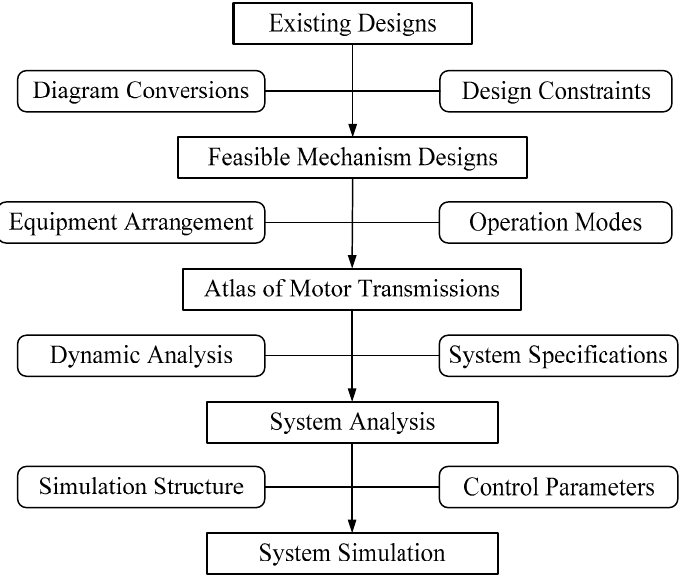
Figure 2. The design process of motor transmissions.